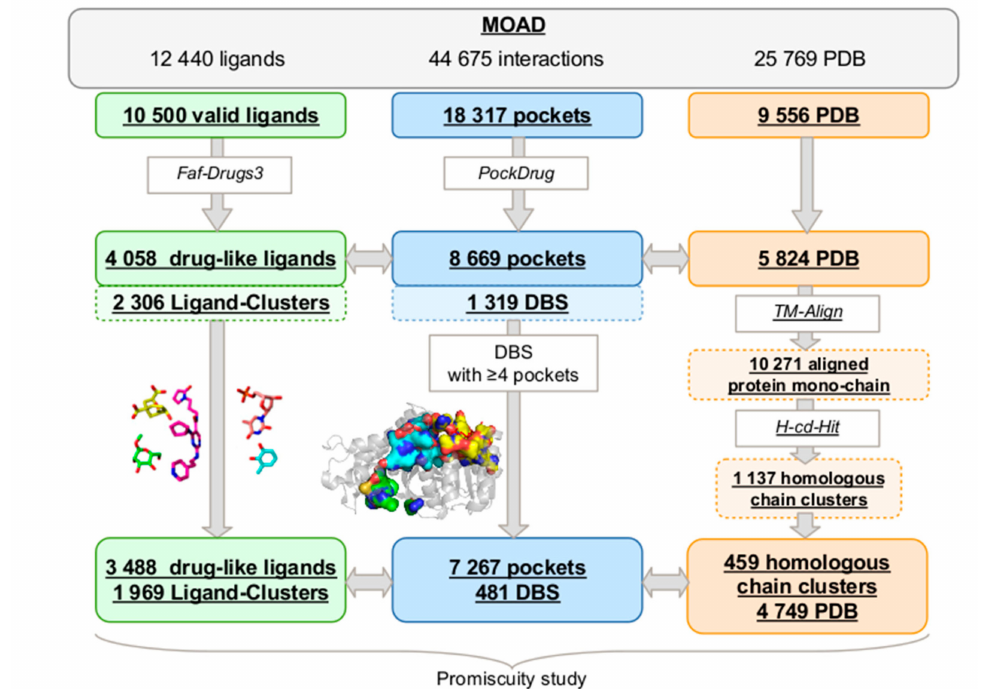
Figure 1. The protocol developed to extract Druggable Binding Sites (DBS) from the Mother Of All Databases (MOAD) data and to determine their promiscuity. We extracted 3,488 valid and drug-like ligands that were regrouped into 1,969 clusters while using the Tanimoto coe ffi cient (green), 459 homologous chain clusters among the 4,749 Protein Data Bank (PDB) files selected using TM-Align [28] to calculate the identity between all the protein chains, and H-CD-HIT [29] clustering algorithms to group the homologous protein chains (orange). The 7,267 pockets clustered in 481 druggable binding sites (DBS) (blue) correspond to the ligands previously selected and all of the homologous protein chains. The promiscuity was calculated from these